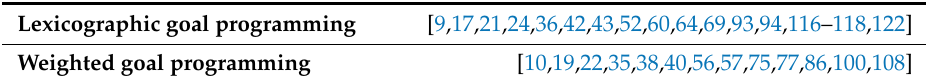
Table 4. Studies in the literature according to lexicographic goal programming and weighted goal programming